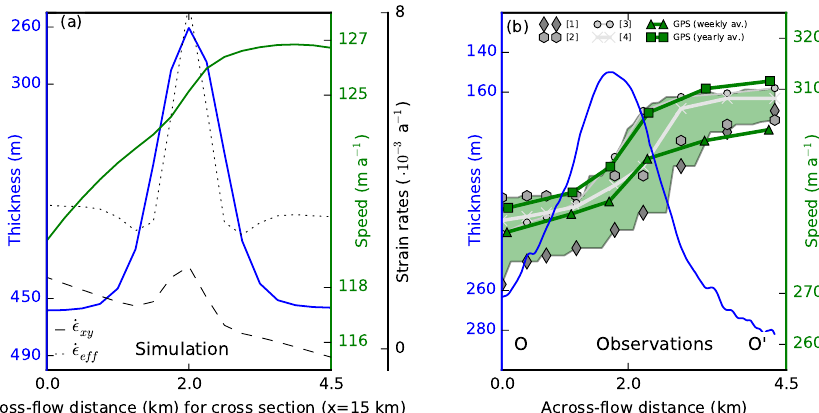
Figure 7. (a) Effective strain rate, horizontal shearing and the along-flow velocity profile for a cross section ( x = 15km) off the simulations shown in Fig. 6 (MS5, Table 1). Prominent features are the velocity step and the enhanced horizontal shearing inside the channel. For comparison, (b) displays GPS inferred ice-flow speed across a channel at RBIS (O-O’, Fig. 1) confirming a step in velocity seen in satellite- derived velocities (1): Callens et al. (2014); (2): Rignot et al. (2011); (3) interferometric SAR from European Remote Sensing satellites (S. Berger, personal communication, 2014), and (4) speckle tracking using the Advanced Land Observing Satellite (S. Berger, personal communication,